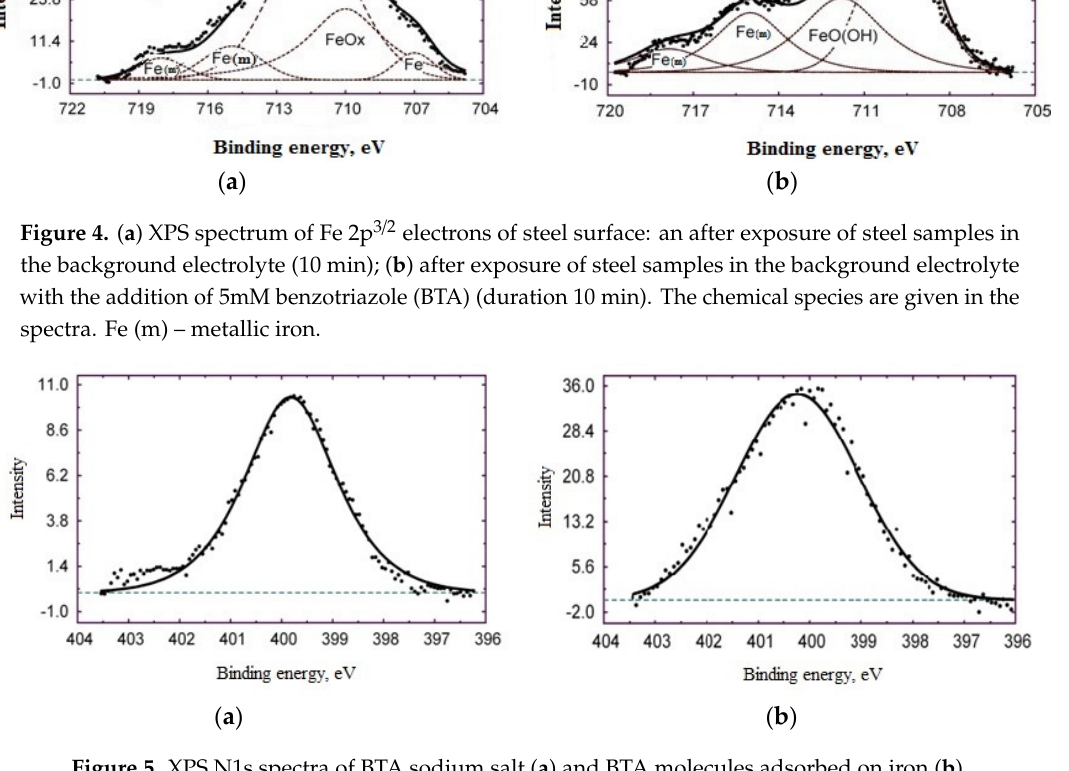
Figure 5. XPS N1s spectra of BTA sodium salt ( a ) and BTA molecules adsorbed on iron ( b ).